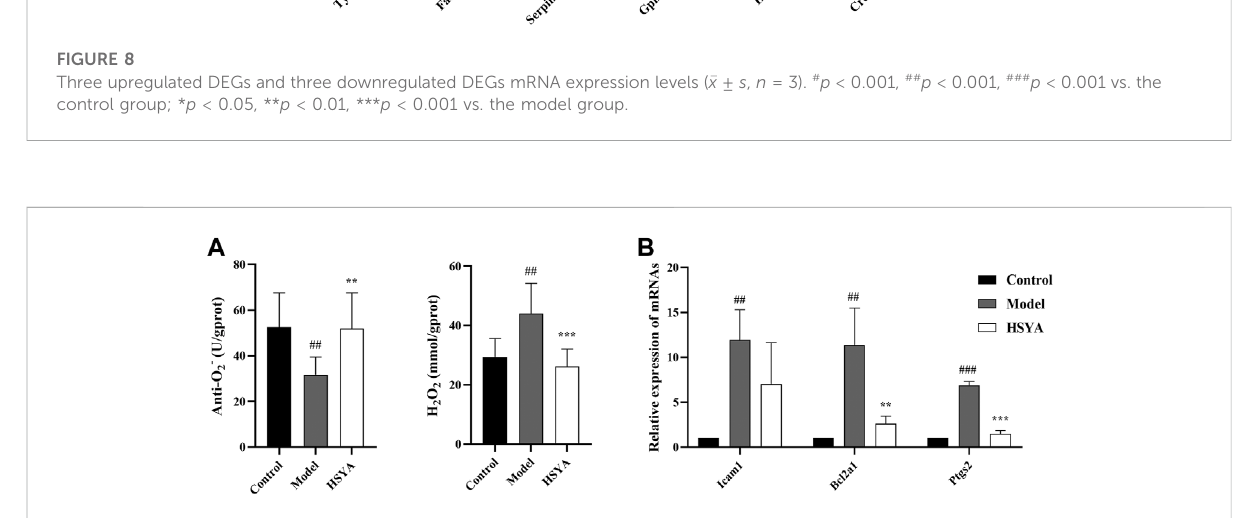
FIGURE 9 Effects of HSYA on the ROS and in fl ammatory genes. (A) The contents of Anti-O 2 − and H 2 O 2 ; (B) The expression levels of in fl ammatory genes ( (cid:1) x ± s , n = 3). ## p < 0.001, ### p < 0.001 vs. the control group; ** p < 0.01, *** p < 0.001 vs. the model